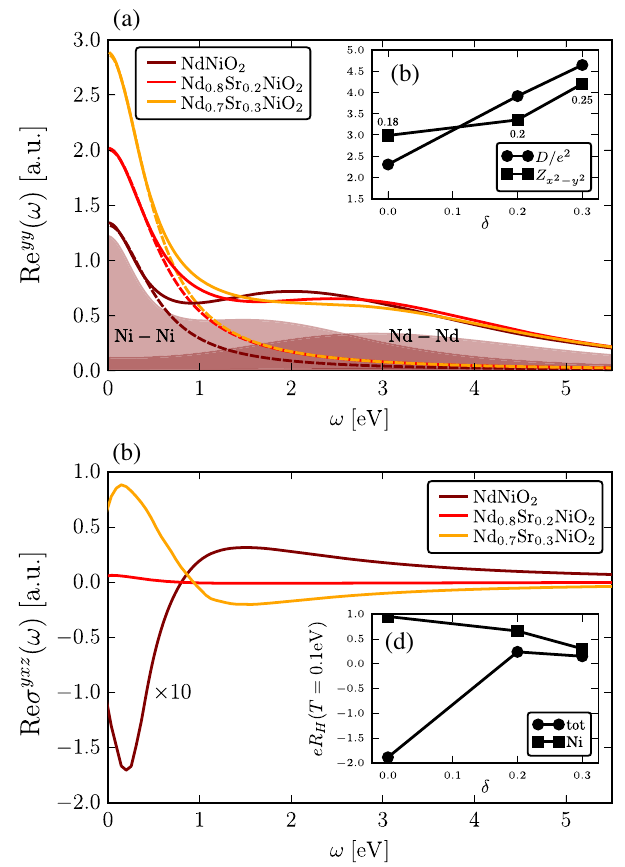
FIG. 5. Linear response conductivities. (a) Optical conductivity as a function of doping. The shading indicates the contribution of the two sites in the undoped compound. (b) Drude weight as a function of doping and comparison to the DMFT estimate of the mass enhancement for the Ni- 3 d orbital (derivative of the x 2 − y 2 local self-energy), with values indicated over the points. (c) Hall conductivity as a function of doping. The curve of the undoped system has been rescaled by a factor of 10 for better